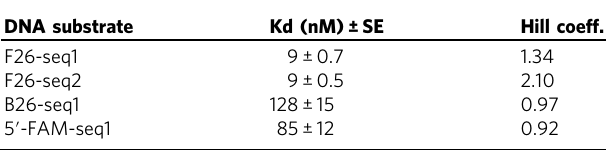
(5 ′ -FAM-seq1), which only bears a 5 ′ -FAM label and no conjugated base in position 26.